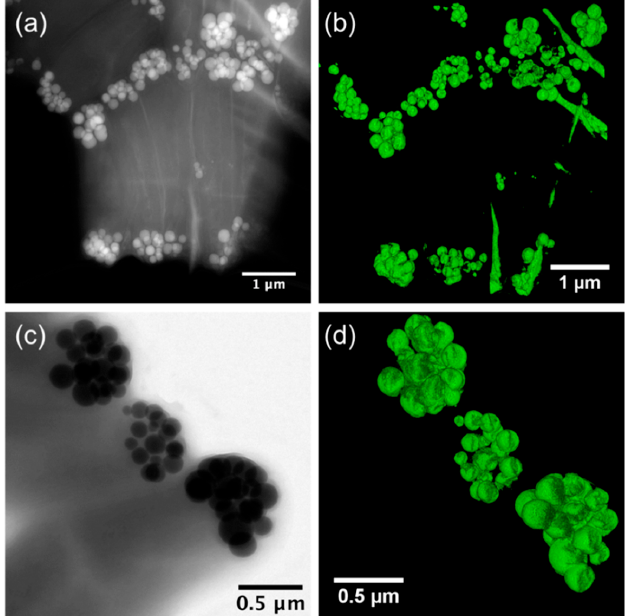
Figure 7. HAADF-STEM ( a , b ) and TEM ( c , d ) tomography of Ca . S. calcipolaris G9. ( a ) HAADF-STEM image of several G9 cells selected for tilt series acquisition and tomographic reconstruction; ( b ) 3-D visualization of the reconstruction from carbonate inclusions showing in ( a ); ( c ) Bright-field TEM image of part of three G9 cells selected for title series acquisition tomographic reconstruction; ( d ) 3-D visualization of the reconstruction from carbonate inclusions showing in ( c ).